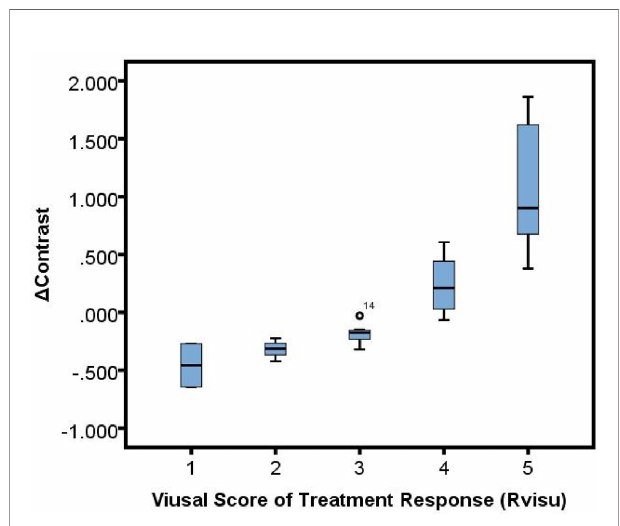
FIGURE 3 | Box plot showed a linear correlation between D Contrast% and Rvisu.